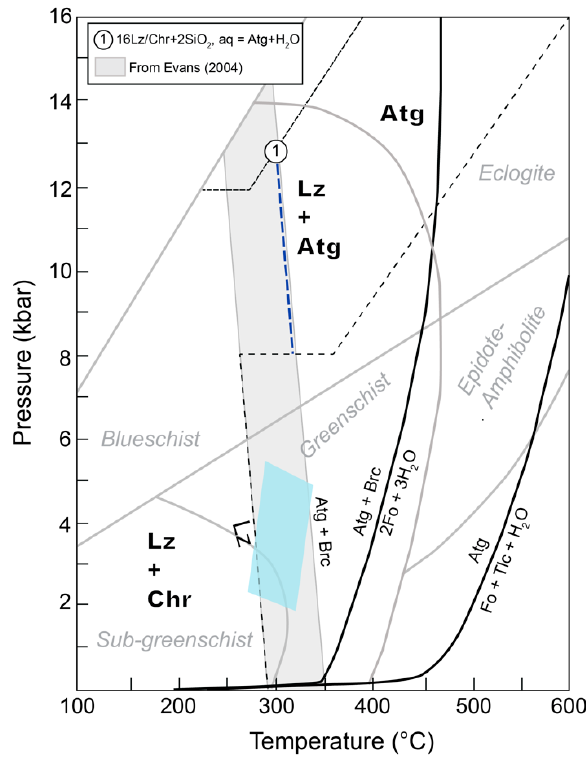
Figure 13. Phase diagram of antigorite and lizardite (from [69], modified). Symbols: Lz-lizardite, Atg-antigorite, Chr-chrysotile, Fo-forsterite, Tlc-talc, Brc-brucite. Reaction (1) is from [68] and occurs in the presence of SiO2-rich fluids by dissolution–precipitation processes. The pale blue area represents the coexisting lizardite and antigorite in the Capo Castello shear zone stability field.